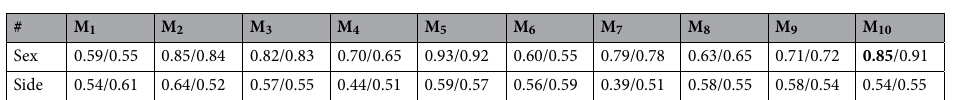
Table 3. Sex and side classification accuracy ACU/AUC of antropometric measures M . The CI95% are not shown to improve readability, but generally range within